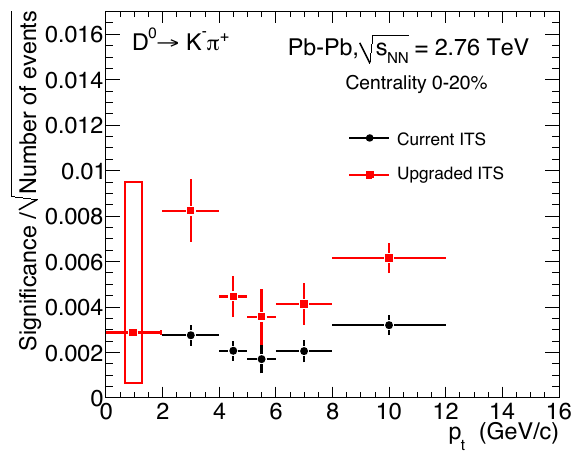
Figure 2. Significance for the measurement of the D 0 as a func- tion of p T normalised to the square root of the number of events. The performance of the upgraded ITS is compared to that of the current detector.